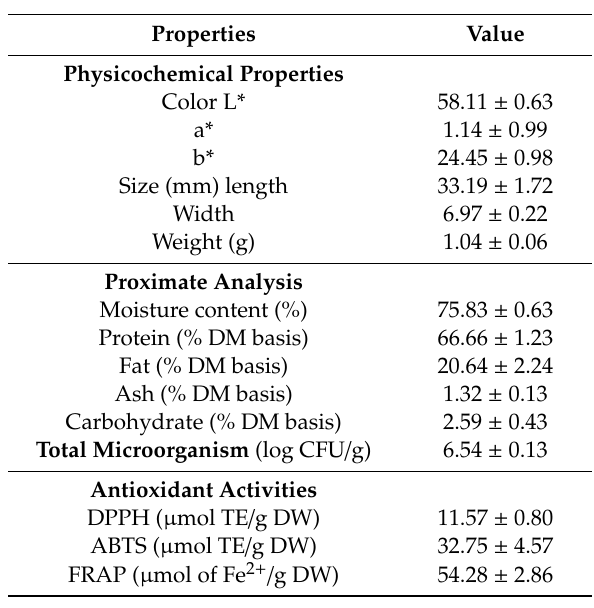
Table 1. Physicochemical properties, total microorganism count and antioxidant activity of fresh Thai silkworm after silking